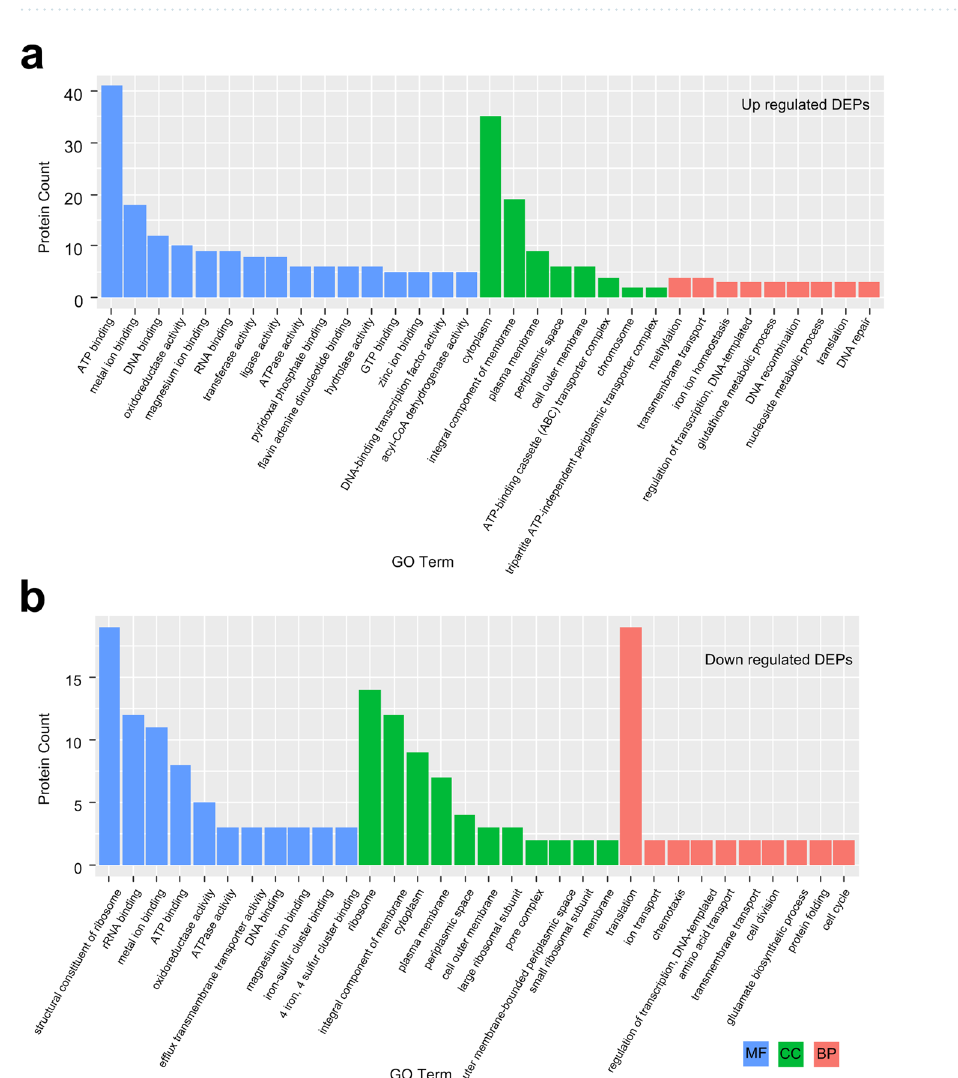
Figure 3. Bar graph of Gene Ontology (GO) enrichment analysis. ( a ) Most enriched GO terms of up-regulated DEPs in 3ABgroup versus 3AB Con group. ( b ) Most enriched GO terms of down-regulated DEPs in 3AB group and 3AB Con